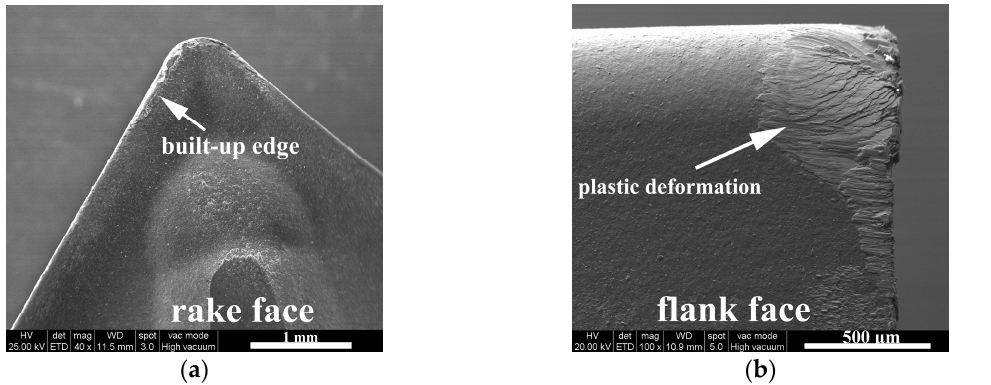
Figure 14. Evolution of VB against cutting time at different feed rates (cutting speed of 50 m/min, depth of cut of 1.0 mm).